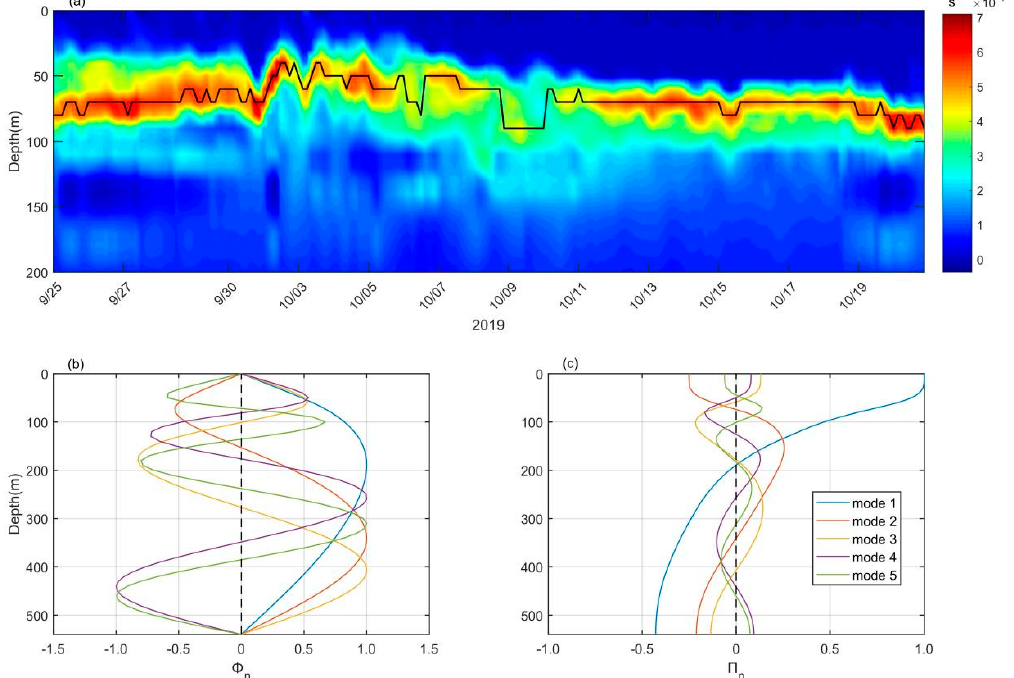
Figure 9. ( a ) Depth − time map of N 2 from 25 September to 20 October 2019 at the mooring. The black line represents the maximum N 2 . Normal modes ( b ) Φ n and ( c ) Π n of the first five baroclinic modes at the mooring. Note that the normal modes shown in ( b , c ) have been normalized.